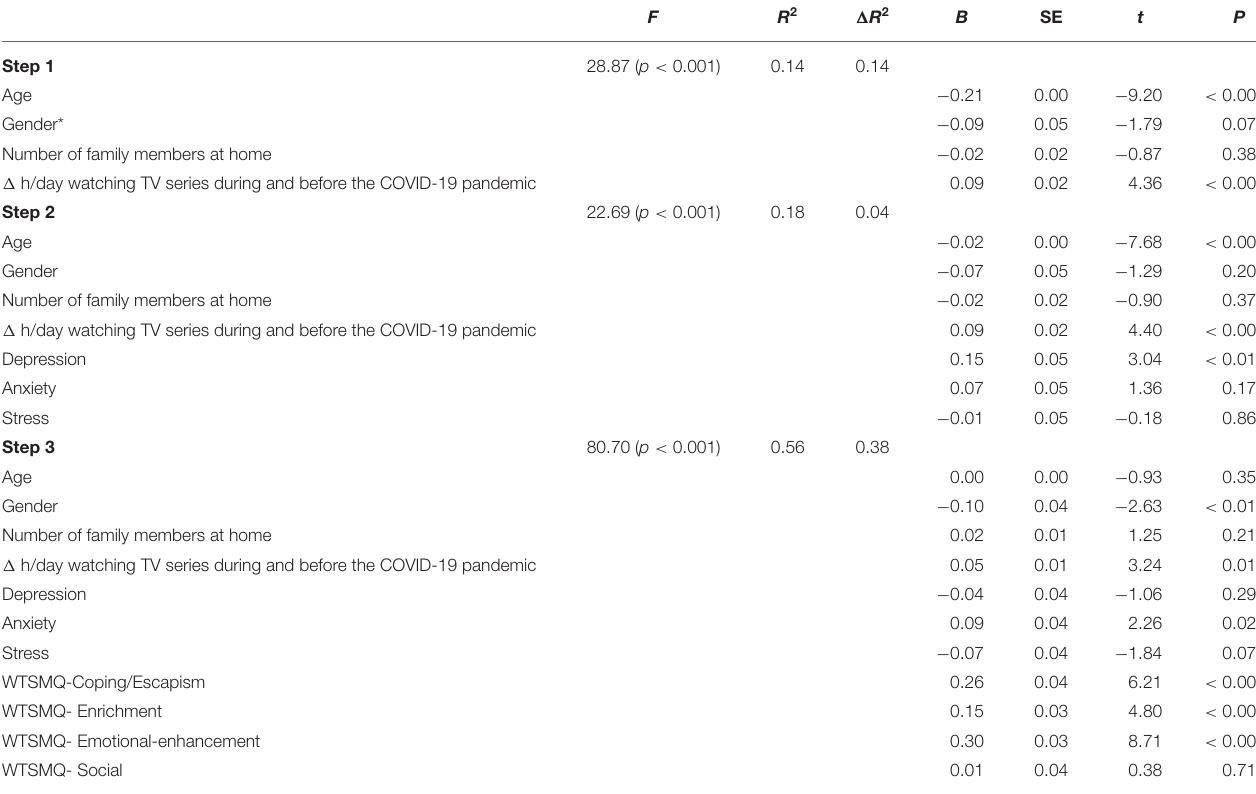
TABLE 3 | Regression: predictors of engagement in watching TV series during the COVID-19